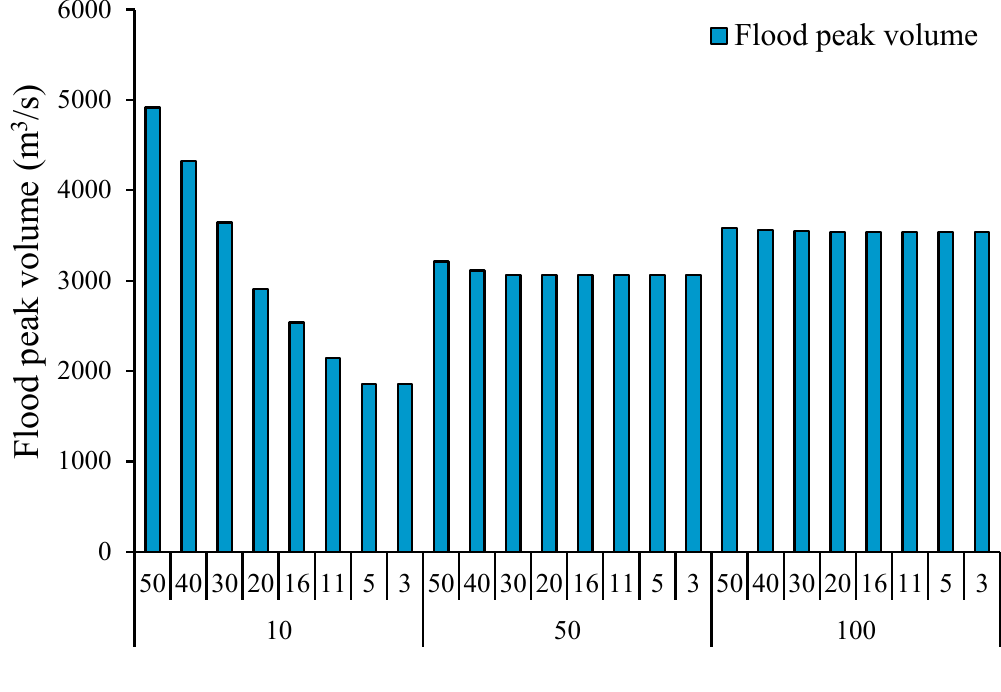
Figure 12. Flood probability of Zhangjiashan under different return periods of Xianyang and Huaxian County.